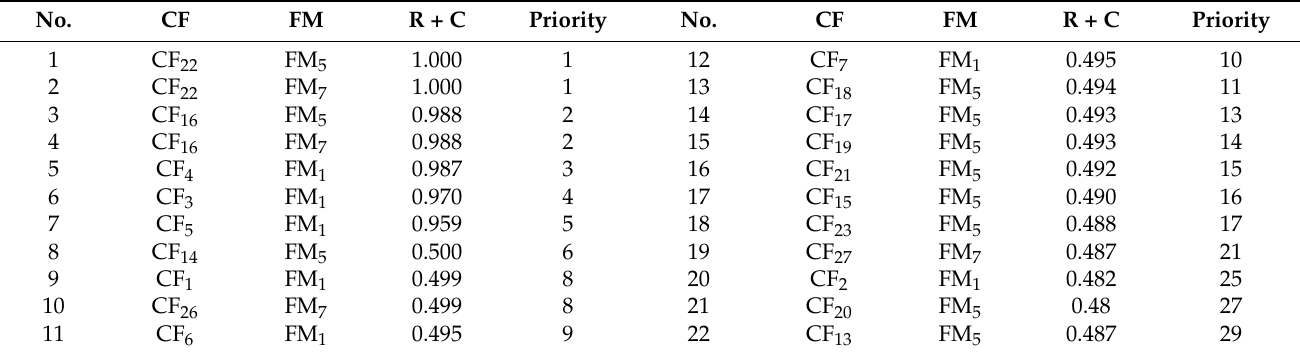
Table 15. Priority of CFs relevant to the top three FMs.